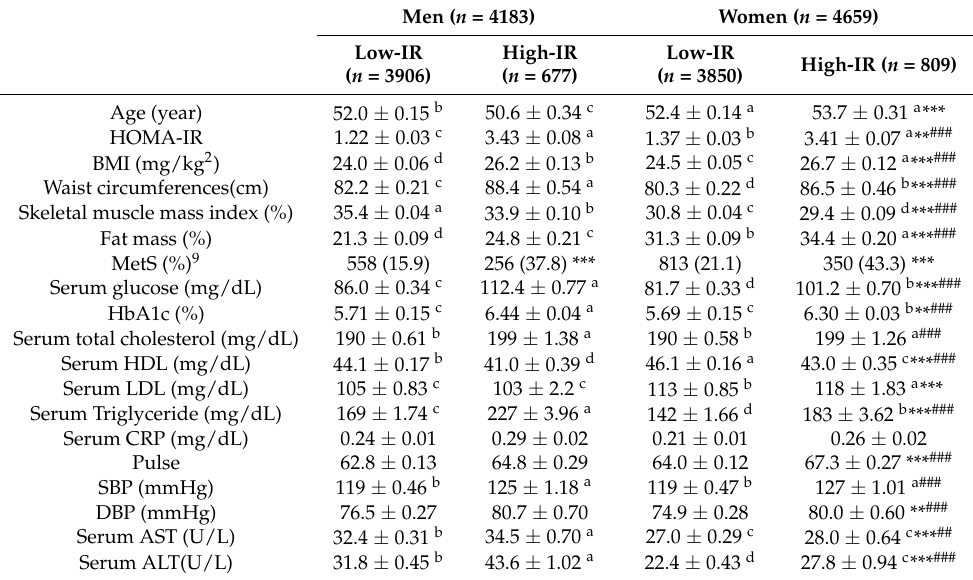
Table 1. Characteristics of the participants in the Ansan/Ansung